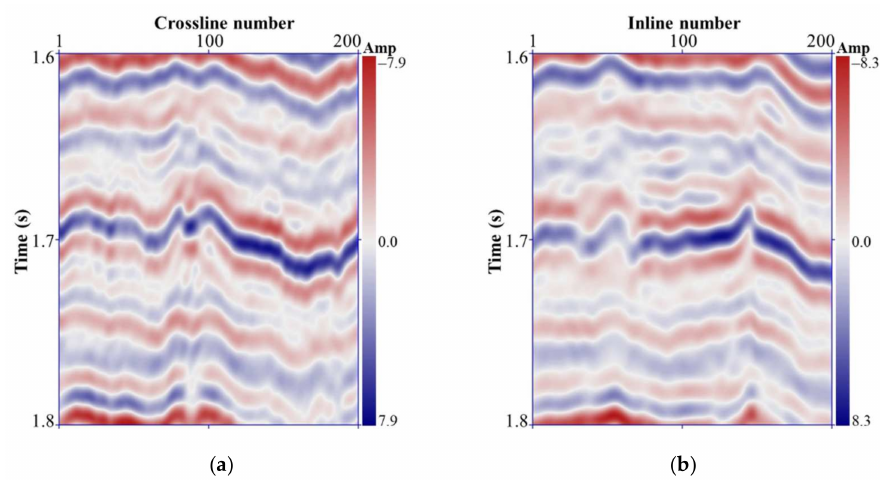
Figure 5. Two profiles seismic data extracted from the input actual 3D seismic data. ( a ) Inline 160; ( b ) Crossline 96.